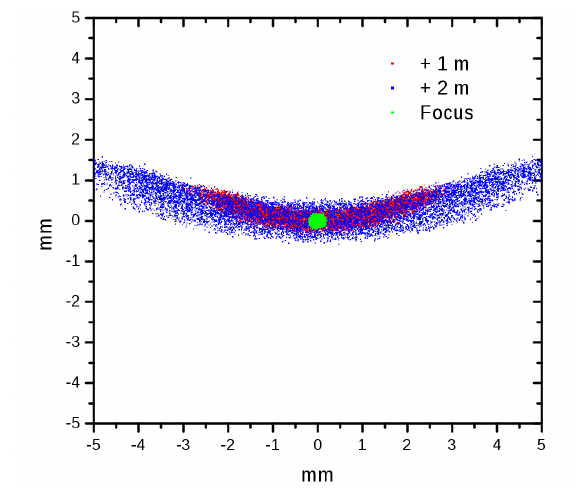
Figure 4: The shape of the focal spot at different positions in the experimental hutch.